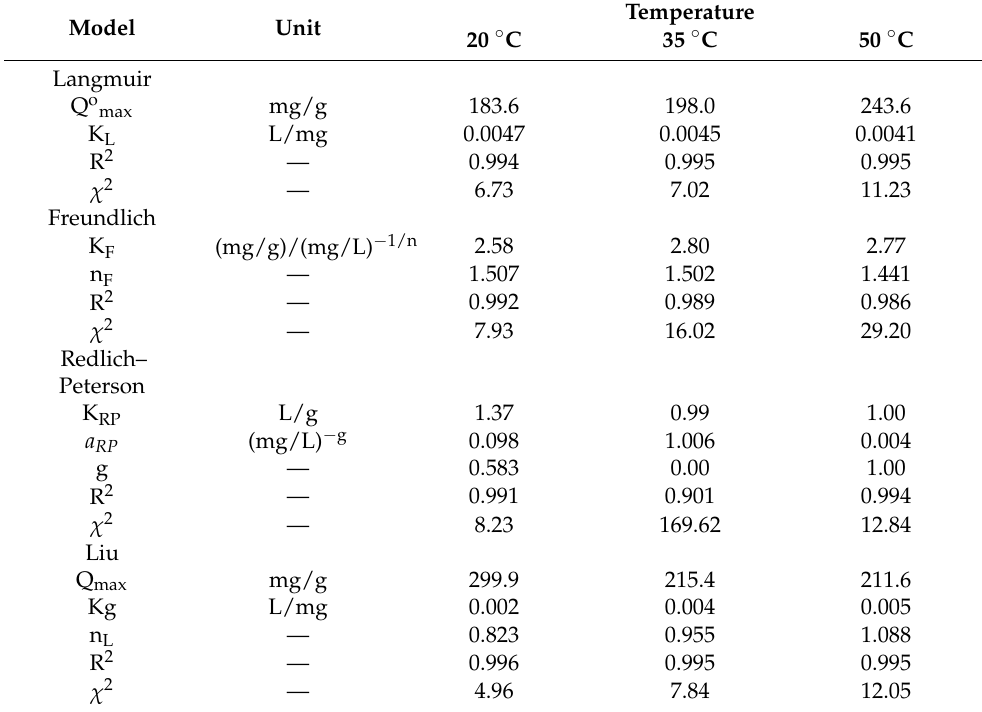
Table 5. Parameters of adsorption isotherms of CV dye onto DSD